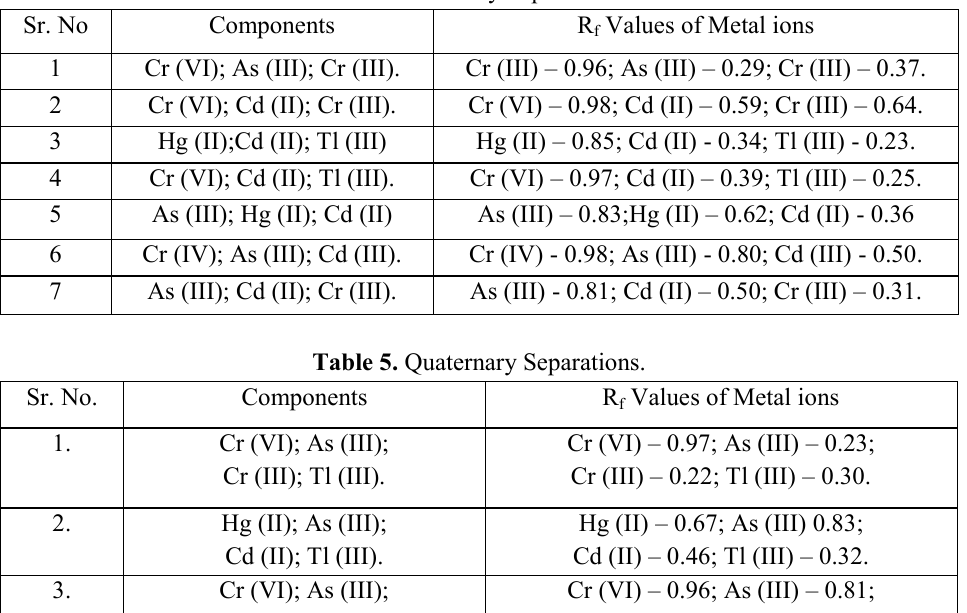
Table 4. Ternary Separations.